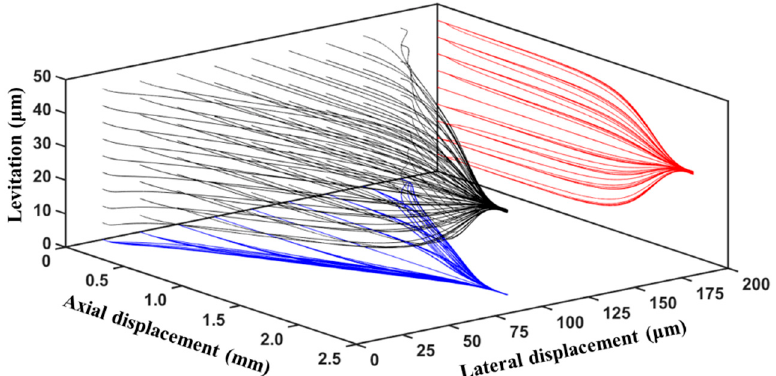
Figure 5. Trajectories of microparticles in the microfluidic device subjected to negative-DEP (nDEP) force ( r p = 2 μ m, V 1 = V 2 = 20 V pp , L e = 2000 μ m, L ch = 2200 μ m, W e = 80 μ m, Q m = 100 μ L/h, W ch = 200 μ m, H ch = 50 μ m).